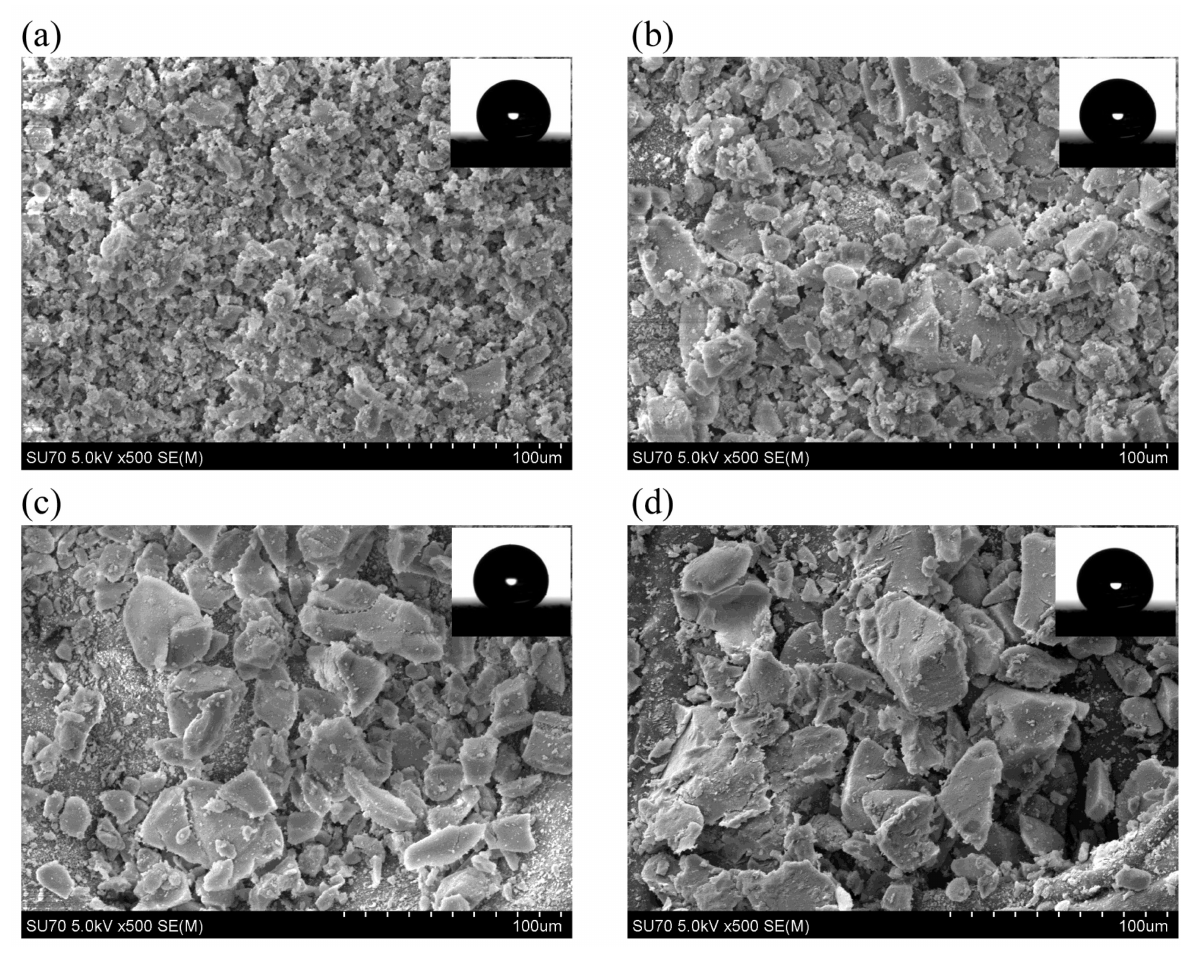
Figure 14. SEM images of superhydrophobic aerogel coatings with different particle-size ranges. ( a ) 0–43 µ m; ( b ) 43–104 µ m; ( c ) 104–150 µ m; ( d ) 150–210 µ m. Upper right inset in each figure shows a water droplet on top of the particular coating. From Samaha et al.